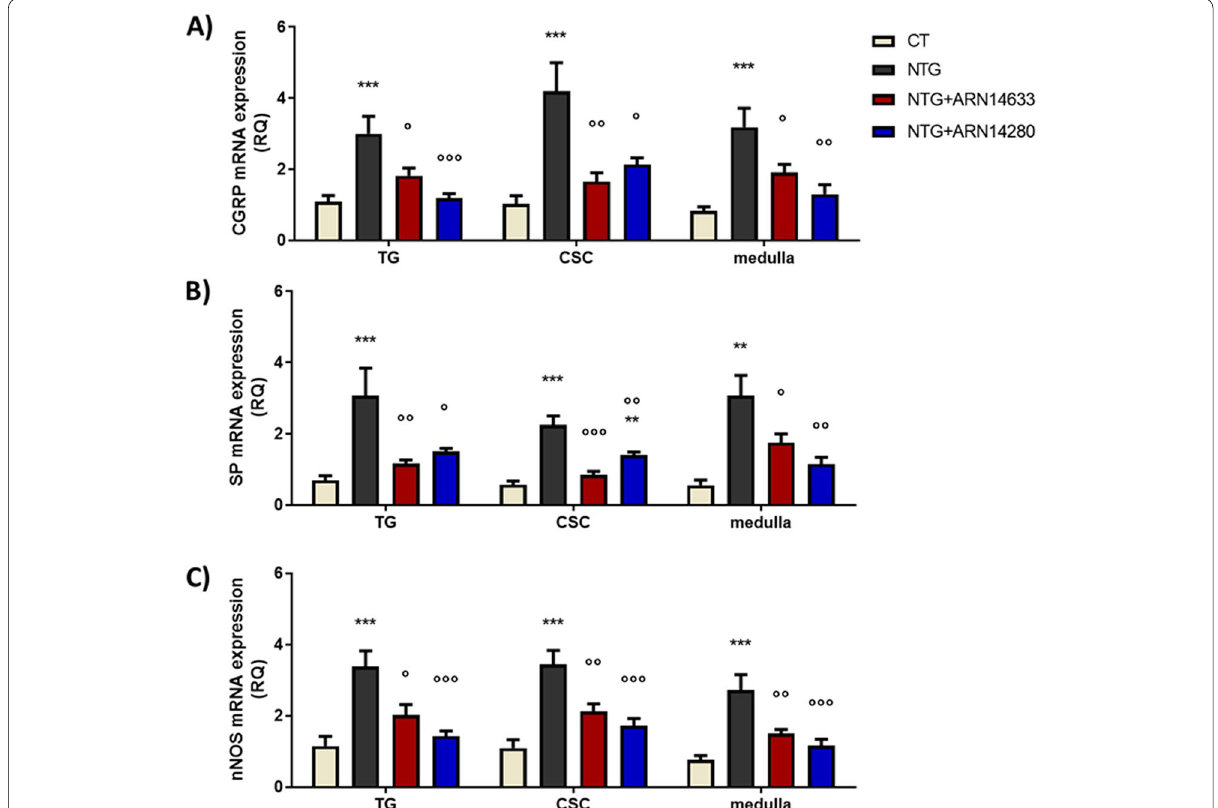
Fig. 4 CGRP ( A ), SP ( B ) and nNOS ( C ) mRNA levels (expressed as relative quantification, RQ) in trigeminal ganglion (TG) and cervical spinal cord (CSC) ipsilateral to formalin injection and medulla in toto of animals treated with NTG vehicle (CT), NTG, NTG 9 per group). Data are expressed as mean SEM; one-way ANOVA followed by Tukey’s multiple comparisons test; ** p < 0.01 and *** p < 0.001 vs CT; ± ° p < 0.05, °° p < 0.01 and °°° p < 0.001 vs